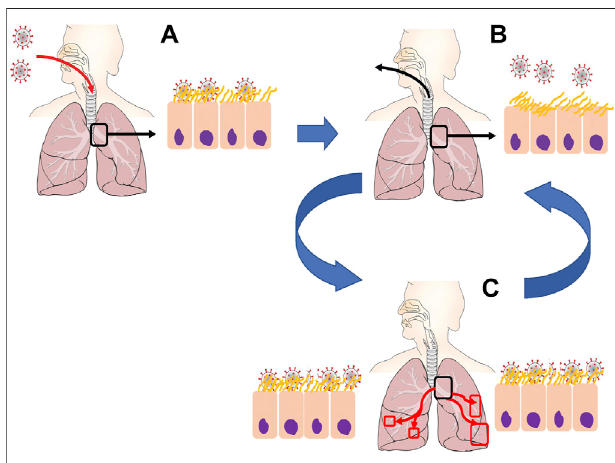
FIGURE 2 | Proposed mechanisms of SARS-CoV-2 infection. (A) Initial inhalation of virions is captured by mucosal liquid lining within the upper respiratory tract or early generations of the bronchial tree (B) Human respiratory activity (e.g., talking, singing, screaming, coughing). causes closing and opening of mucosal membranes, rupturing fl uid droplets containing infectious virions. (C) Microaspiration of oropharyngeal fl uid and/or re-inhalationofaerosolizedvirionsdepositintolowergenerationsoftheairway tree, allowing for replication and increased virus density throughout the deep